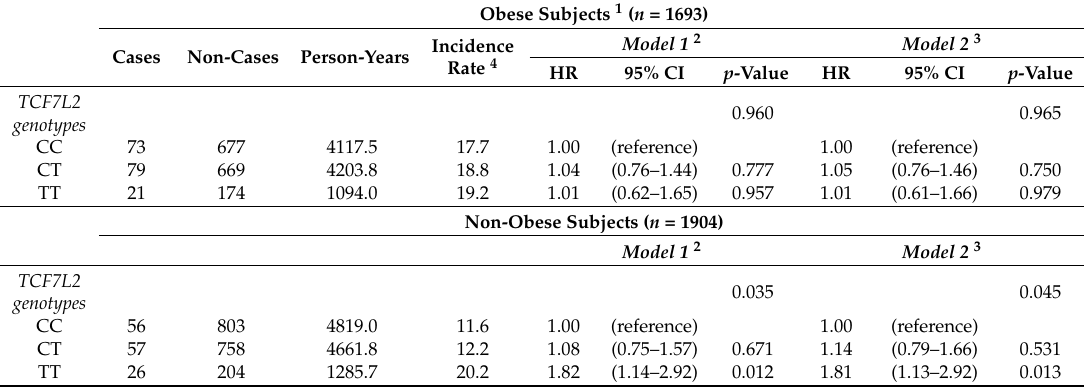
Model 2: Adjusted for variables in model 1 plus total energy intake, adherence to the Mediterranean diet, alcohol intake, smoking, physical activity, dyslipidemia, and hypertension at baseline; 4 Crude incidence rates are expressed per 1000 person-years of follow-up.